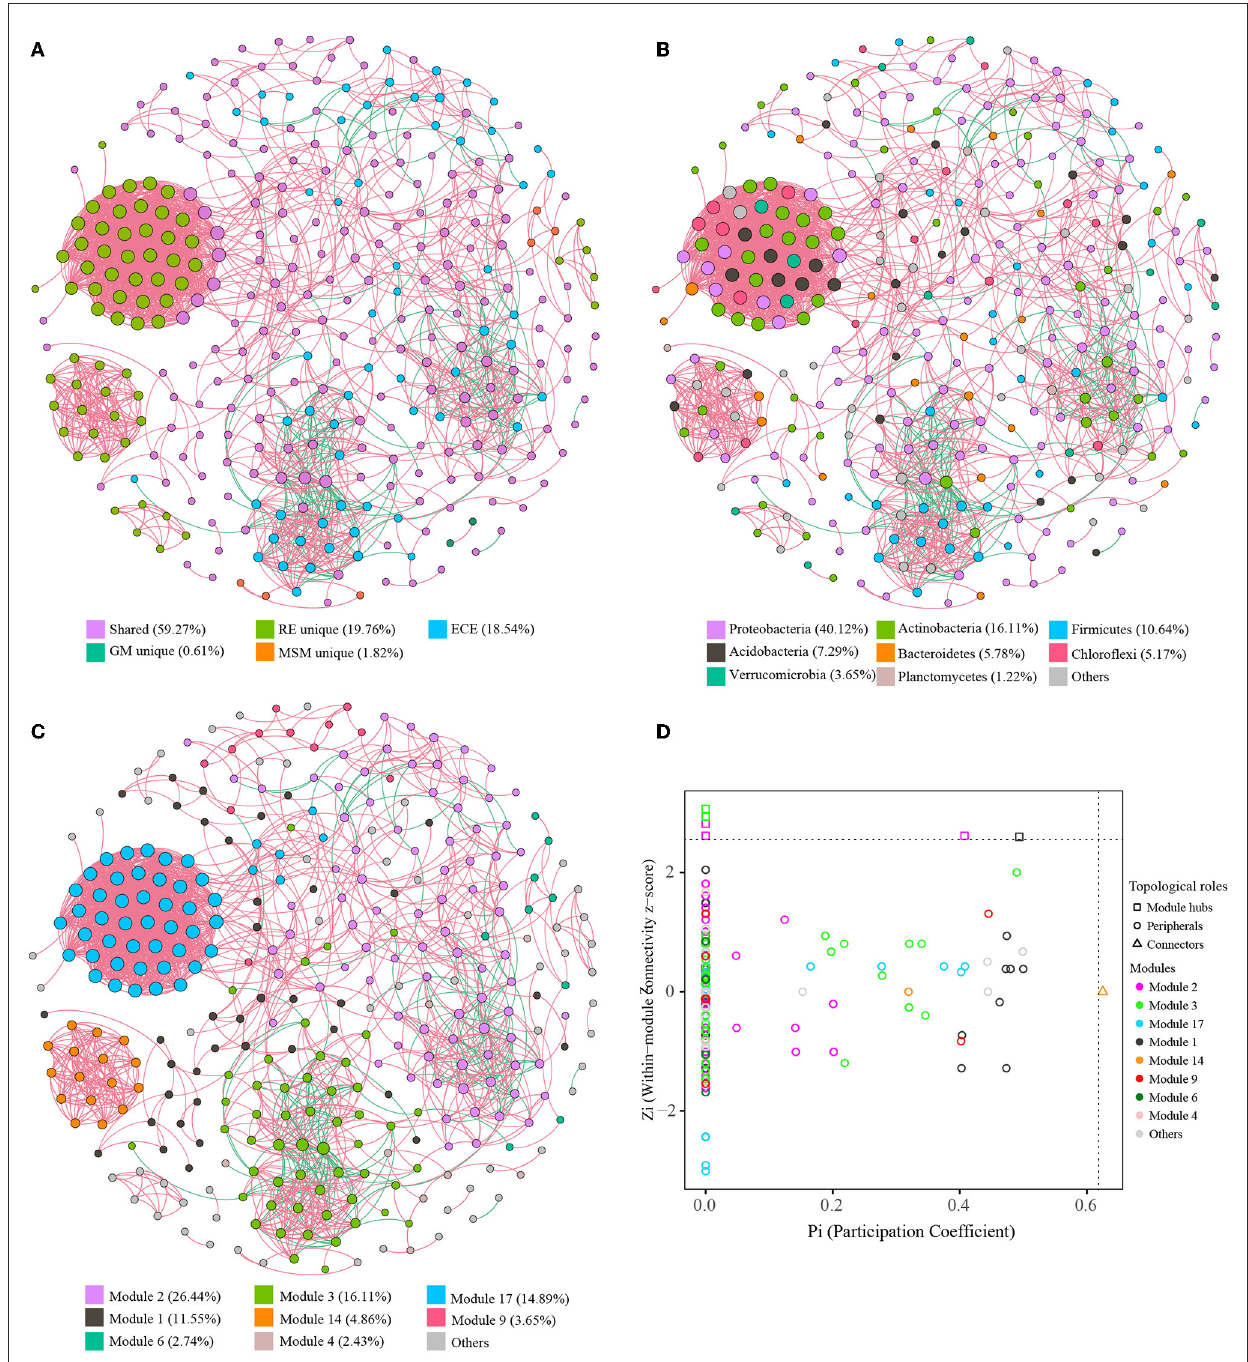
FIGURE6 Characteristics of co-occurrence networks with OTUs. Co-occurrence networks with OTUs colored by the grouping (A) , taxonomy (B) , and modularity (C) , successively. Nodes represent the retained OTUs under the strict threshold. Edges (red lines) represent statistically significant positive correlations of each OTU pair, while edges (blue lines) represent statistically significant negative correlations of each OTU pair. The size of nodes represents the connective degree of each node in the network. (D) The distribution of bacterial OTUs on the Zi- Pi plot based on their topological characteristics. Table 1 presents a list of abbreviations for the groups used in the